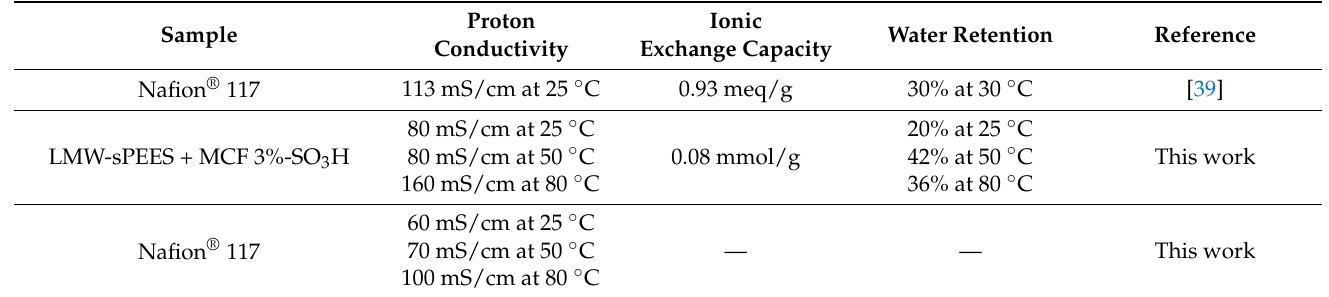
Table 5. Summary of the performance properties of the LMW-sPEES with MCF 3%-SO 3 H membrane and Nafion